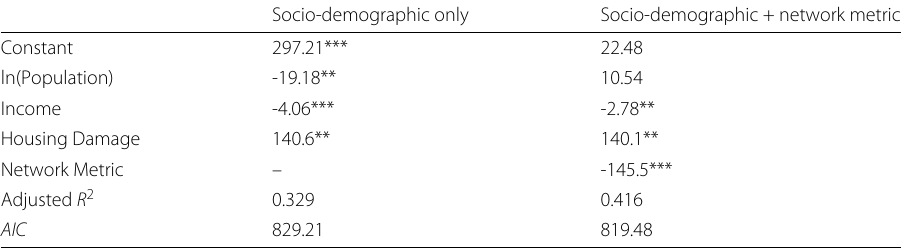
Table 6 Ordinary Least Squares Regression Results with W ( N F ) as network metric Socio-demographic